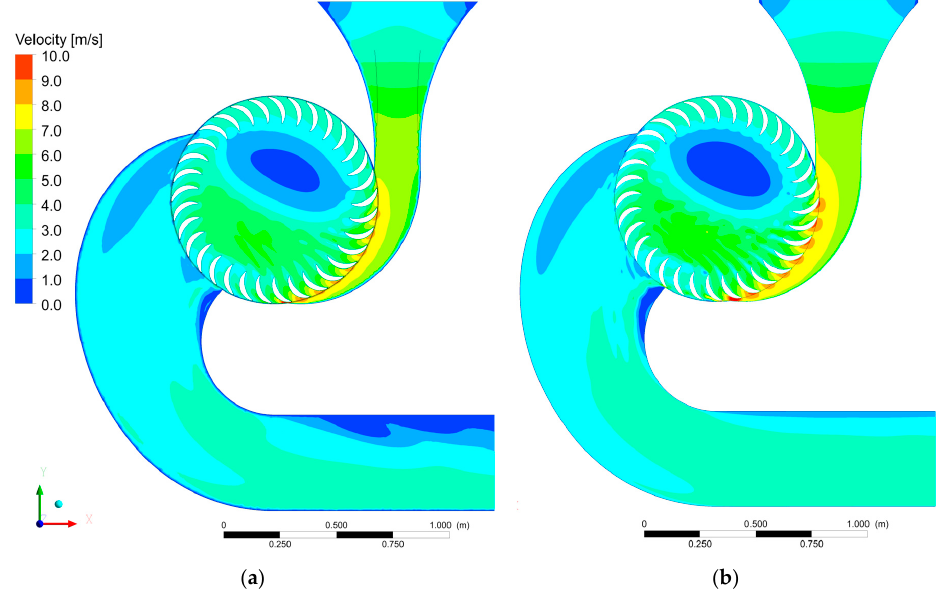
Figure 13. Velocity field of UL-PRS: ( a ) 3D and ( b ) 2D simulations. Figure 14a,b show the head field, respectively, in the symmetry plane of the 3D sim- ulation and the 2D one. From this comparison, similar conclusions can be derived.